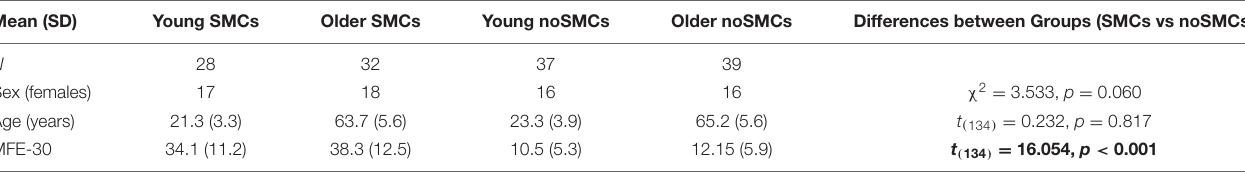
and Electrode (Fz and FCz) as within-subject factors, and Group (SMCs, noSMCs) and Age (young, older) as between-subject factors. The parameters of amplitude and latency were used as dependent